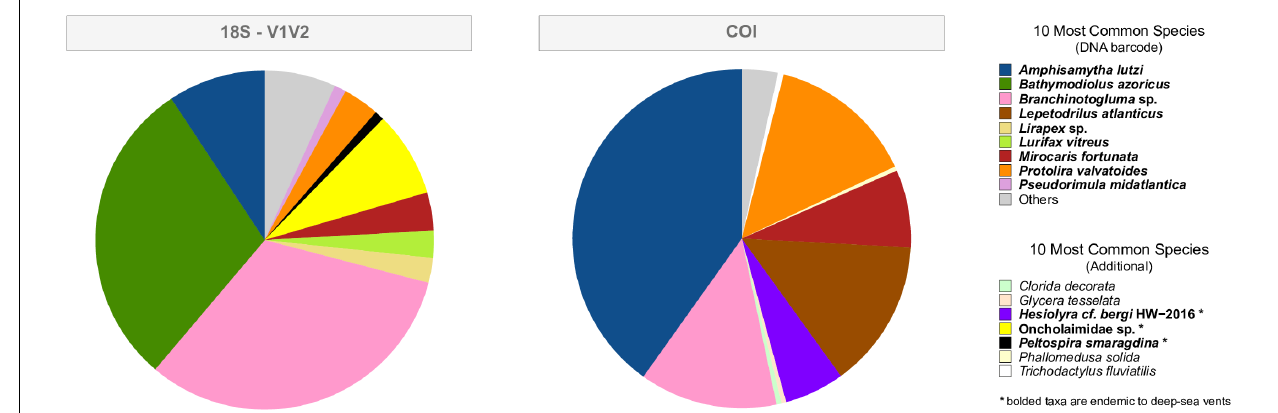
FIGURE 3 | The top 10 most common species, in terms of sequence abundance, for the 18S-V1V2 and COI eDNA datasets. “DNA barcode” are those species that were physically collected from Montségur and DNA barcoded in the current project ( Table 1 ). “Additional” are species that were not DNA barcoded by the present project yet were within the NCBI GenBank database prior to the taxonomic assignment of eDNA. Species in bold are those found at hydrothermal vents, while non-bolded species are not found at hydrothermal vents. The presence of these non-vent assignments suggests that these sequences were assigned to the closest taxon within the database, and not that these non-vent species are present in the